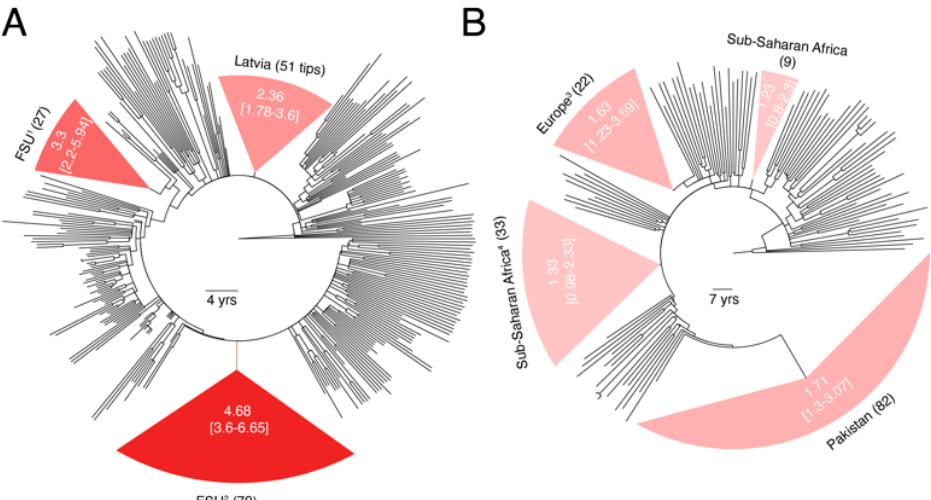
Figure 3. Comparison of pol substitution rates between sub-subtypes A6 and A1. ( A ) Dated phylogeny comprising of a larger sampling of A6 sequences is displayed. Partitions corresponding to monophyletic clades of viruses sampled from countries in the FSU are highlighted. Numbers in parentheses indicate total number of tips in a clade. Values inside the clade indicate the calculated mean substitution rate along with the 95% CI for that clade. Rates for the entire tree (i.e., without partitions) and remaining branches (i.e., excluding partitions) were 3.23 × 10 − 3 and 2.98 × 10 − 3 , respectively. RTT slope was 4.91 × 10 − 3 ( R 2 = 0.477, r = 0.69). ( B ) Dated phylogeny comprising of a larger sampling of A1 sequences is displayed. Rates for the entire tree (i.e., without partitions) and remaining branches (i.e., excluding partitions) were 1.62 × 10 − 3 and 1.29 × 10 − 3 , respectively. RTT slope was 2.35 × 10 − 3 ( R 2 = 0.16, r = 0.39). Other details similar to ( A ). 1 Includes 26 samples from Russia and 1 sample from Armenia, 2 includes 64 samples from Russia, 3 from Uzbekistan, 2 from Armenia, and 1 from Latvia, 3 also includes 1 sample from Australia, 4 also includes 9 samples from India and 1 sample from